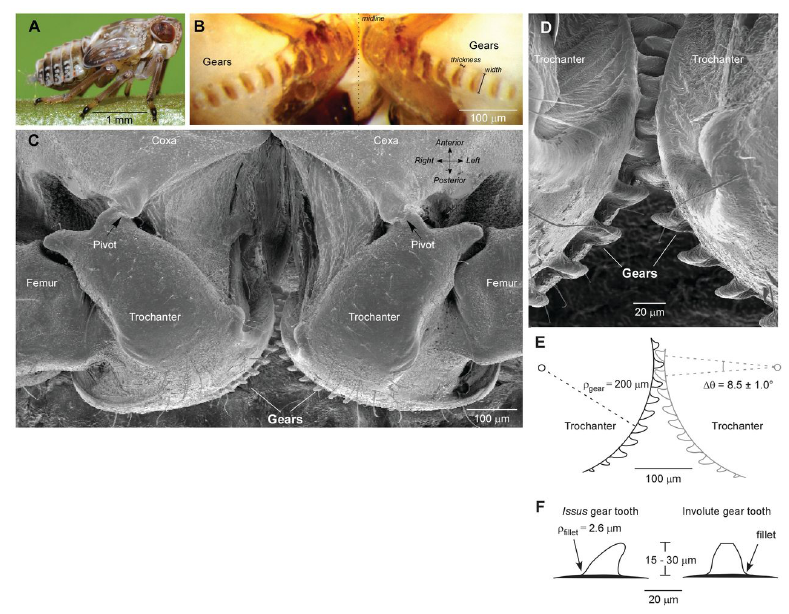
Figure 1. Naturally occurring geared mechanism from